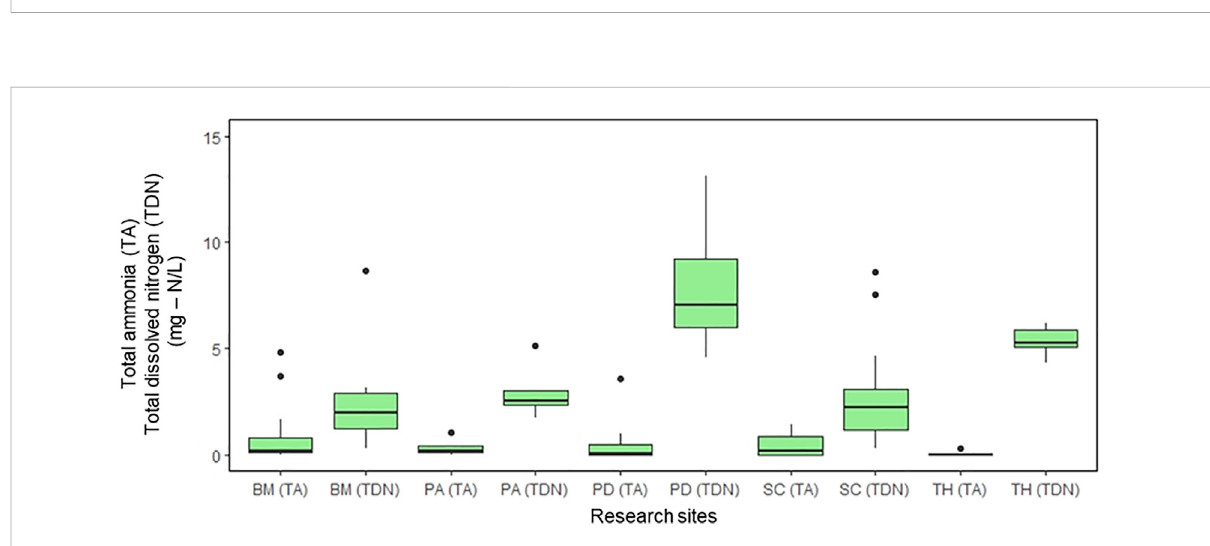
FIGURE 9 Groundwaterqualityresultsfor totalphosphorus anddissolved reactivephosphorus atthedifferentfensites(SC,Scraghbog;PD, Pollardstown fen; BM, Ballymore; TH, Tory